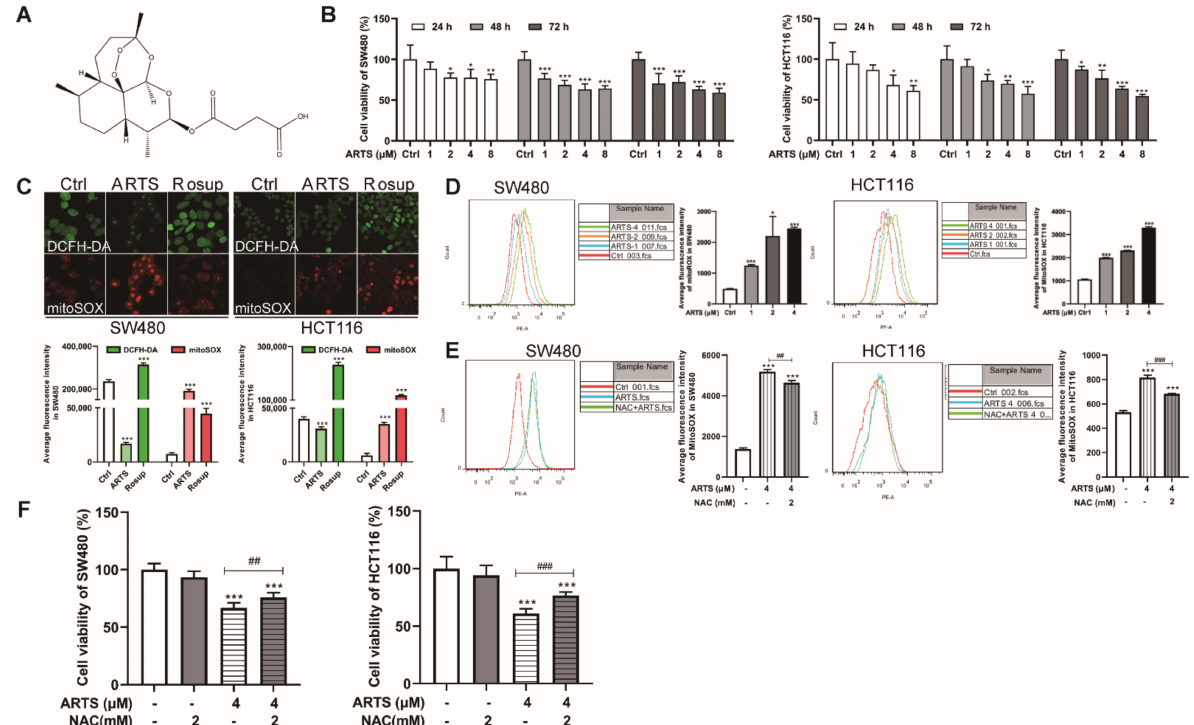
Figure 1. Artesunate inhibited cell viabilities partially due to excessive mitochondrial ROS. ( A ) The endoperoxide structure of artesunate. ( B ) Artesunate inhibited cell viabilities of SW480 and HCT116 dose-dependently. The colorectal cancer cell lines, SW480 and HCT116, were seeded in 96-well plates and treated with artesunate at 1, 2, 4, and 8 µ M for 24, 48, 72 h. Cell viabilities were detected via CCK8 assay. ( C ) Artesunate caused mitochondrial ROS generation. Cells were seeded in glass-bottomed dishes and treated with artesunate (4 µ M) for 72 h. DCFH-DA (Green) and MitoSOX TM Red (Red) was used to label the total intracellular ROS and mitochondrial specific ROS respectively. Images were captured by confocal microscope (Scale bar = 25 µ m). Rosup was used as a positive agent of ROS inducer. ( D ) Mitochondrial ROS was increased dose-dependently. Cells were probed with MitoSOX TM Red after artesunate treatment. The fluorescence intensity of MitoSOX TM Red was record by flow cytometry to indicate the mitochondrial ROS level. The ROS scavenger NAC helped to ( E ) decrease the mitochondrial ROS, and ( F ) restore cell viabilities in treated SW480 and HCT116. NAC was used at a concentration of 2 mM and added alone or together with artesunate (4 µ M) for 72 h before cell viability assay and MitoSOX TM Red incubation. * p < 0.05, ** p < 0.01, and *** p < 0.001 vs. Ctrl. ## p < 0.01, and ### p < 0.001 vs. cells treated with artesunate alone. Data were shown as mean ±